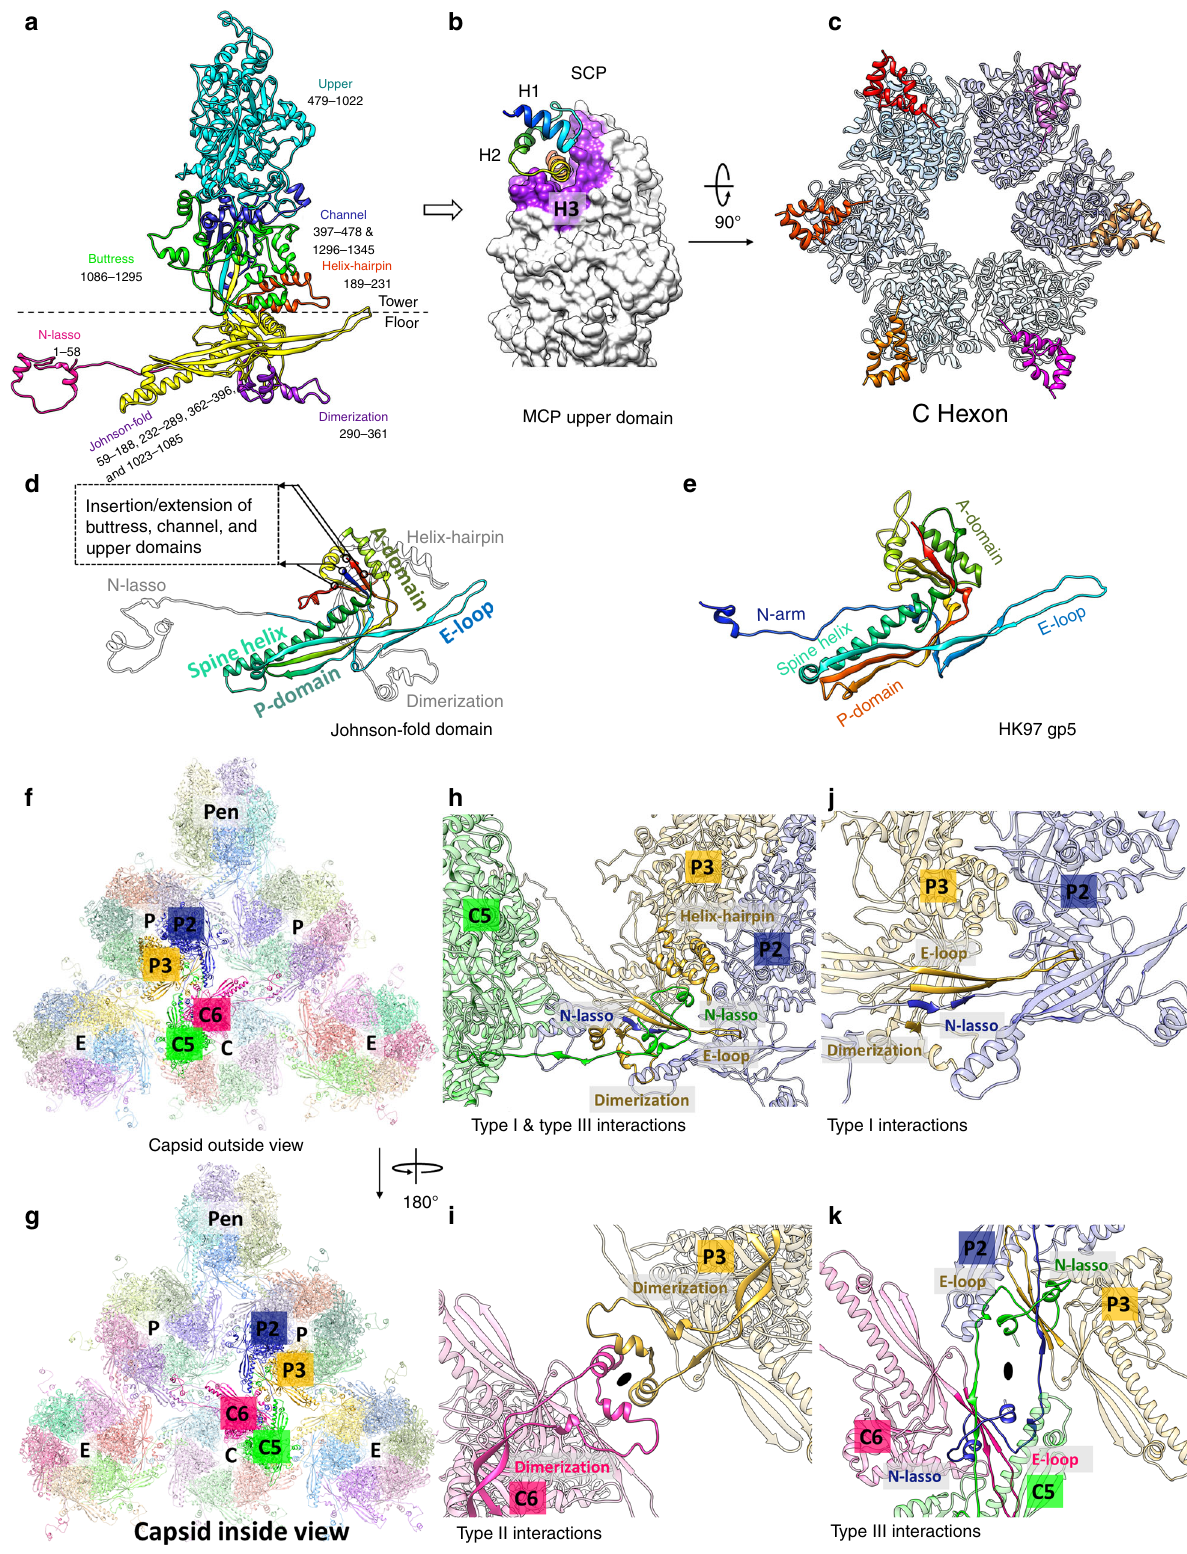
Atop the triplex, four pU11nt subunits cluster into a tetramer (Fig. 1c – e) in a “ V Λ ” -shaped, dimer-of-dimers con fi guration and their subunits can be classi fi ed into four types based on their relative locations in the dimer-of-dimers: pU11nt-a-1, pU11nt-a- 2, pU11nt-b-1, and pU11nt-b-2 (Fig. 4b). These four pU11nt